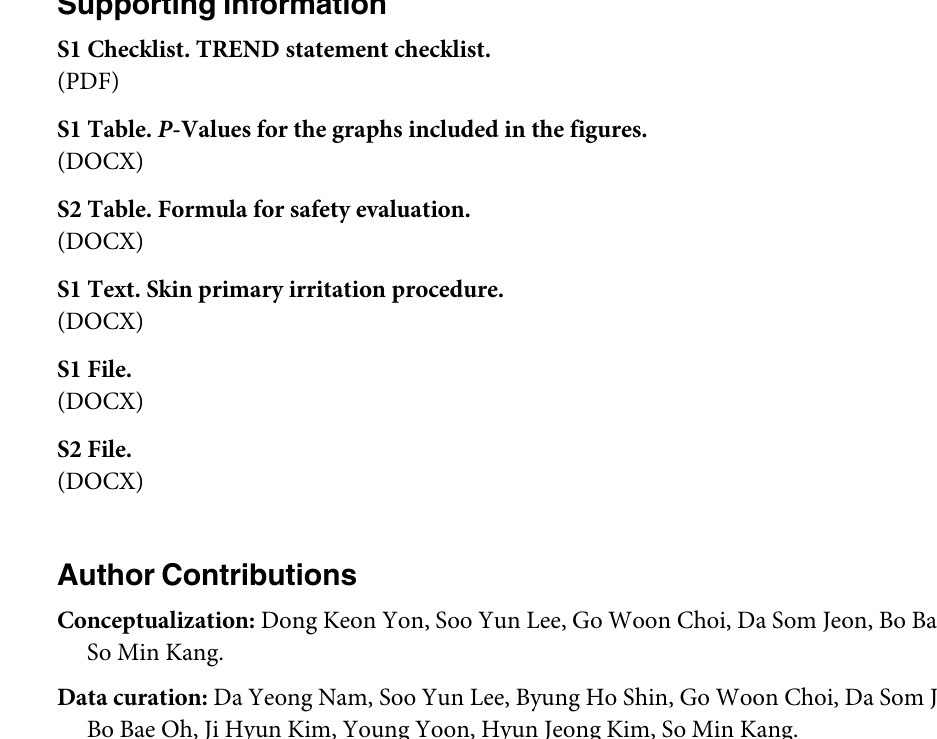
S1 Table. P -Values for the graphs included in the figures. S2 Table. Formula for safety